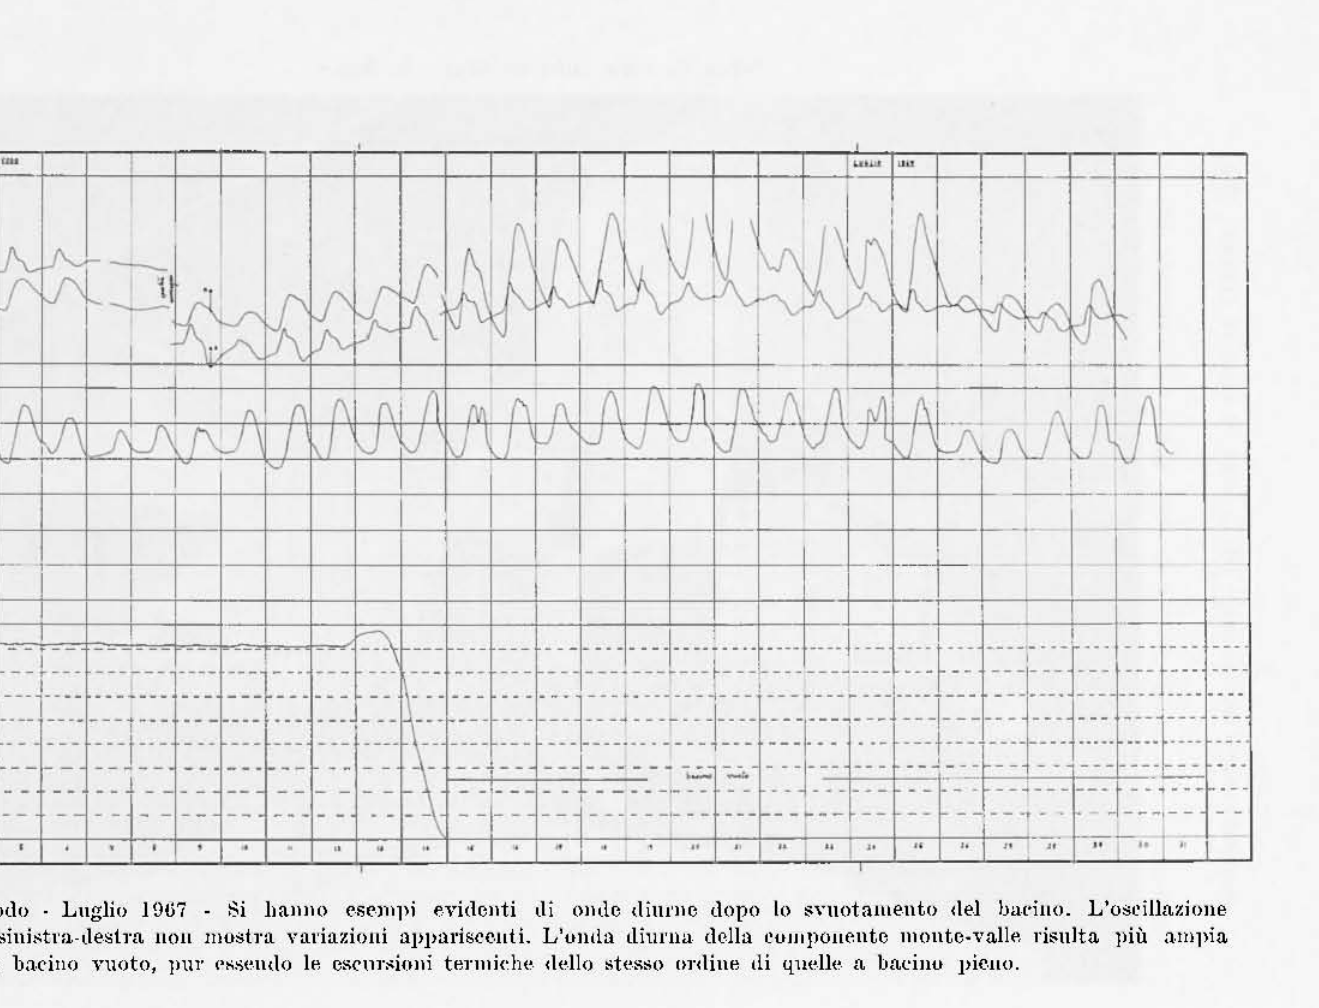
Fig. 2 - Diga di Vodo . Luglio l!Hi7 . Si llanno cscmpi cvidenti di onde diUl'ne dopo lo o<vuotaillento <leI bal"illo. L'oscillazione diurna in dirpzione sini,;tra·tlestra 11011 mostra val'iaziolli al'l'aris(,cllti. L'olUla lliul'lla della ('oJJlpOIlC'nte monte·vallf', rio<ulta più a.mpia a ba.eiuo vuoto, pUl' p~.wndo le eo<c\lT,;ioni teTlllidw <IdIo steo<so onlille (li quelle a bacillo